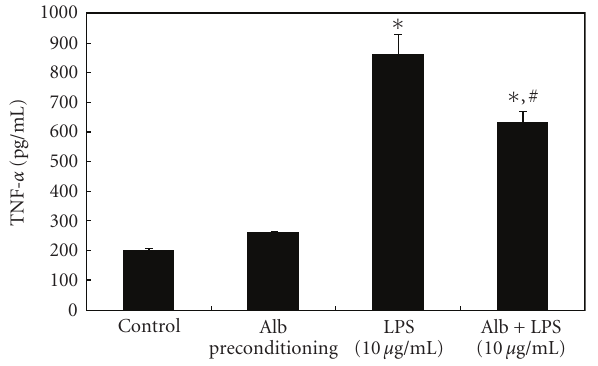
Figure 3: Albumin preconditioning abrogates LPS-mediated TNF- α gene expression in RAW264.7 macrophages.RAW264.7 peritoneal macrophages were preconditioned with BSA (1mg/mL) for 18h prior to a subsequent treatment with LPS (10 μ g/mL). LPS treat- ment resulted in a significant increase in TNF- α expression, as measured by ELISA. Albumin preconditioning, however, signifi- cantly abrogated LPS-mediated TNF- α expression. All experiments were performed in triplicate with 3 wells per condition ( ∗ P < . 05 compared to control; # P < . 05 compared to LPS